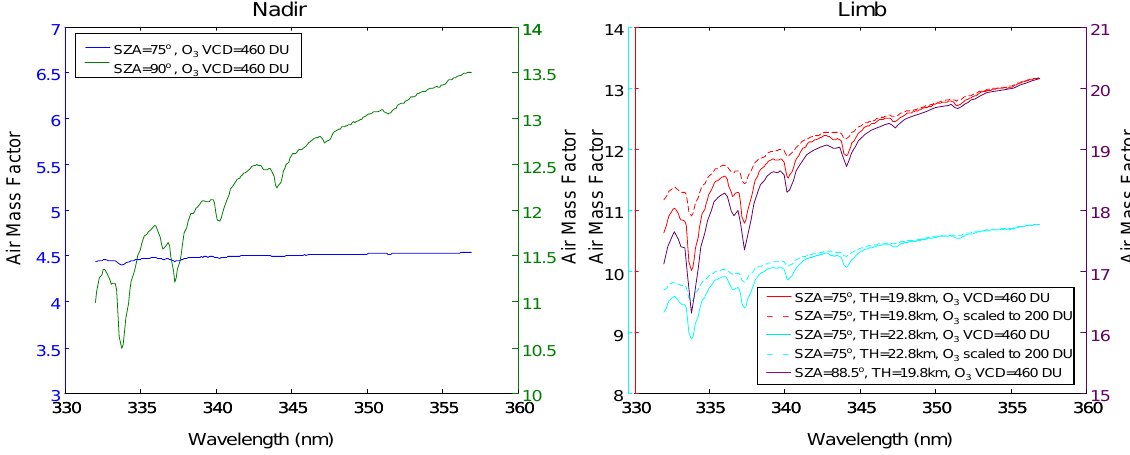
Fig. 1. AMFs of ozone for nadir (left) and limb geometry (right) as function of wavelength for different atmospheric scenarios (see legend and Table 1 for details).